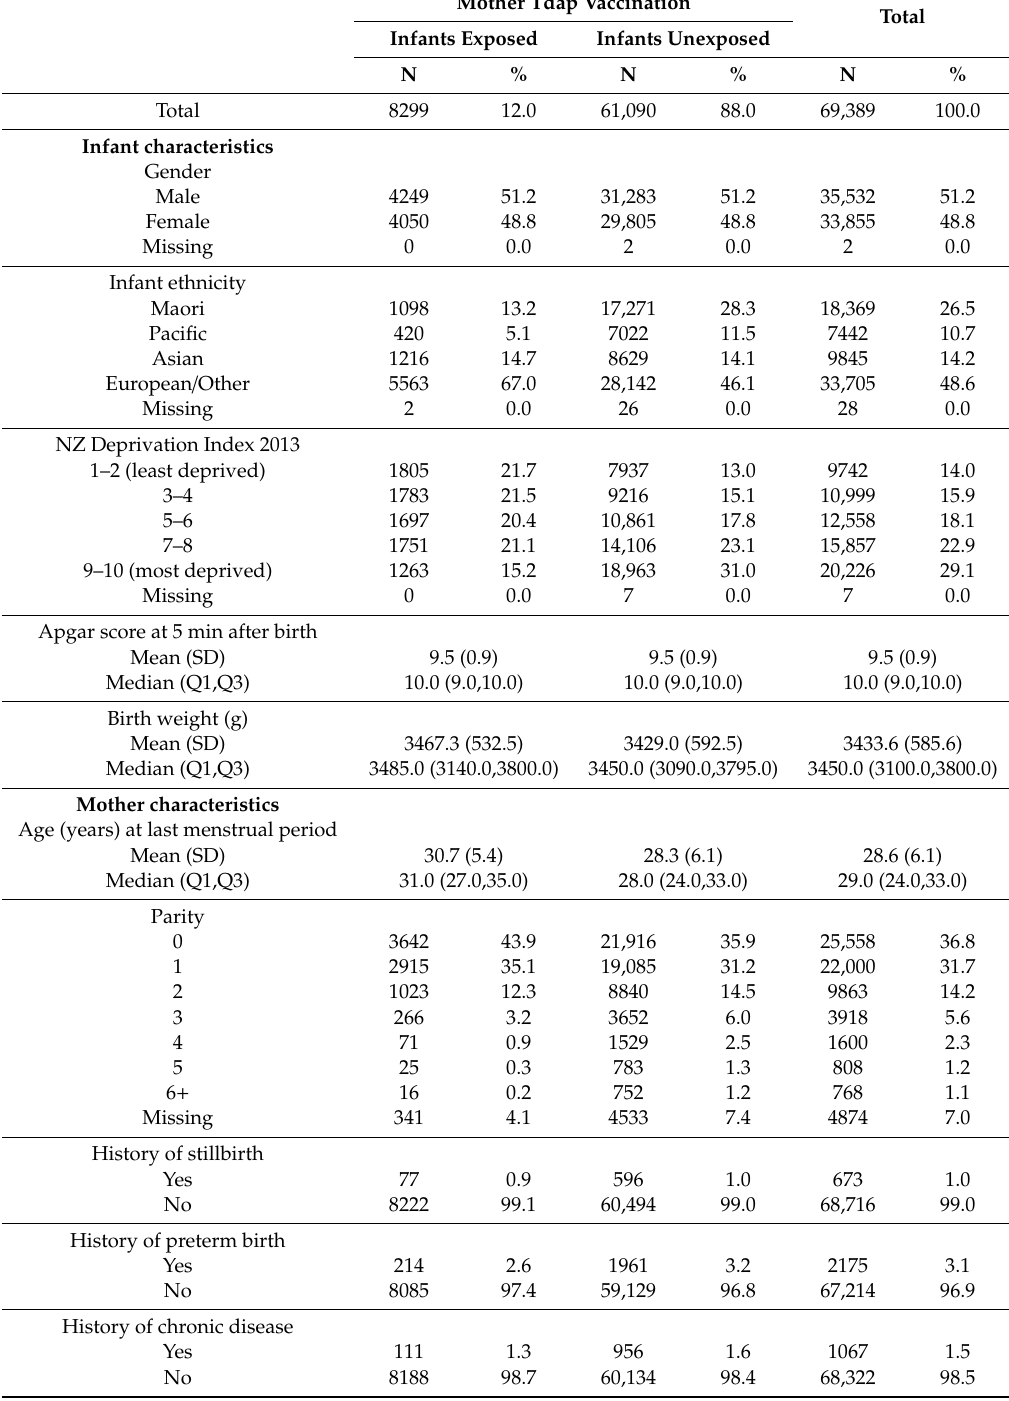
Table 1. Demographics of infants born to women * who were eligible † to receive funded vaccination during pregnancy between 1 January and 31 December 2013, New